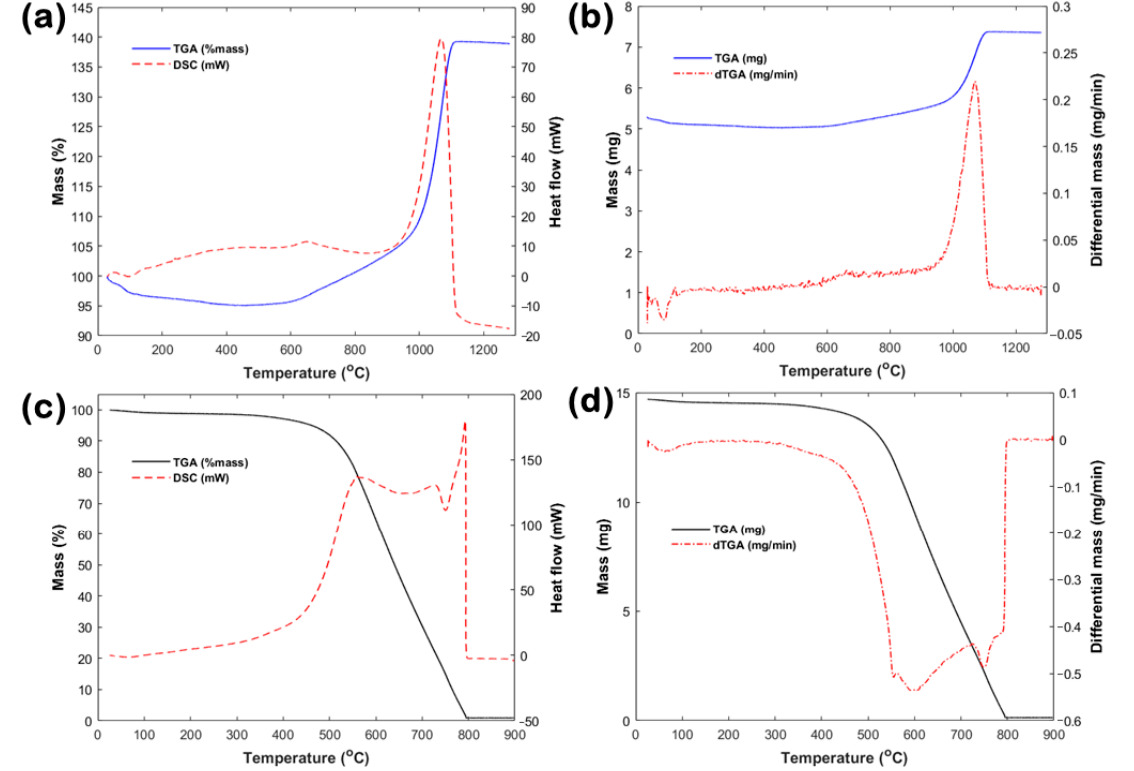
Figure 7. ( a ) Combined TGA / DSC and TGA / dTGA curves in synthetic air for ( a , b ) BNNTs and ( c , d ) CNTs; dTGA stands for di ff erential TGA (temporal mass